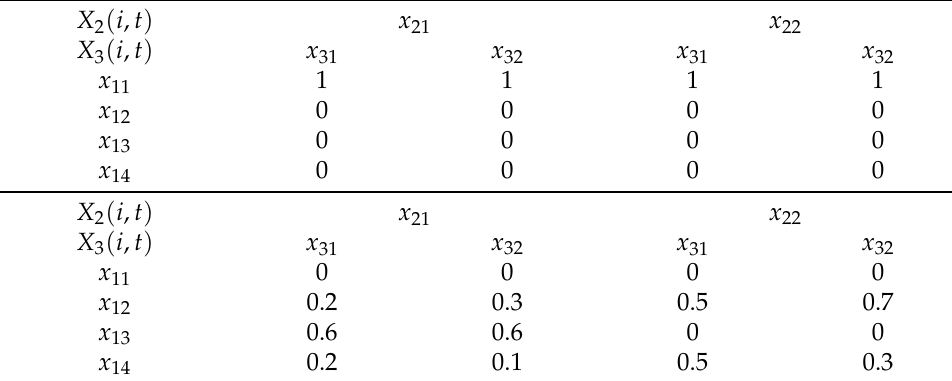
Table 8. CPDs of the future state without infectious devices and with the initial states: susceptible (on the left) and infectious (on the